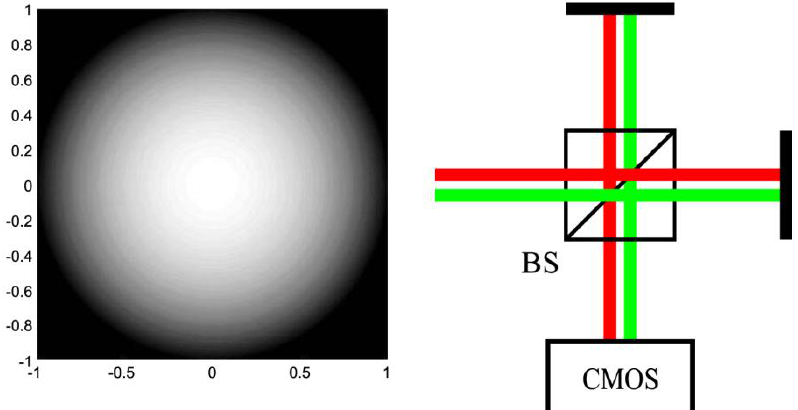
Figure 7. Proposed experimental set-up: Twyman-Green interferometer (TGI) for exact focusing and optical